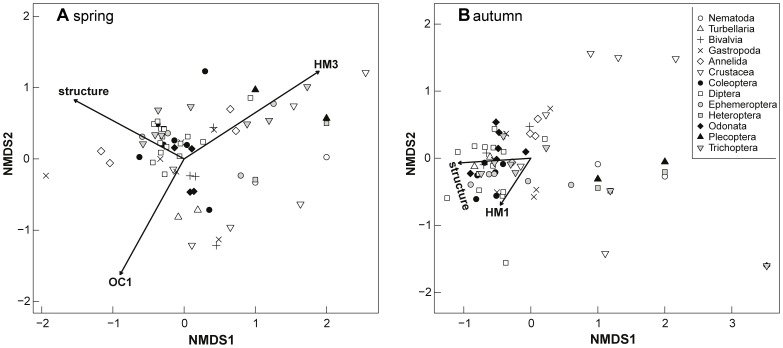
NMDS biplot of taxa and environmental variables.Displayed are variables with a significant impact (p<0.05) for sampling campaign in spring (A) and autumn (B). HM, components of the principal component analysis (PCA) with heavy metals; OC, components of the PCA with organic contaminants; structure, structural degradation. Spring: two convergent solutions, two dimensions, stress = 0.17; autumn: two convergent solutions, two dimensions, stress = 0.21).